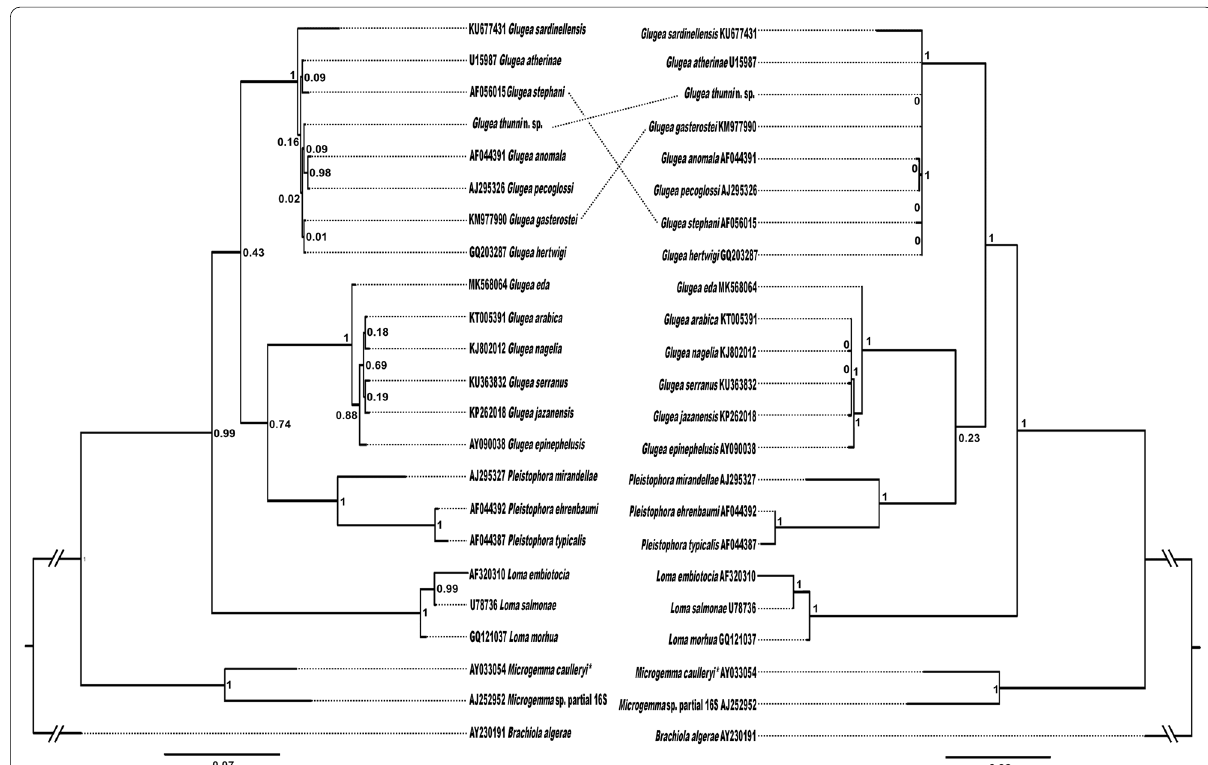
Fig. 5 Confronted bayesian inference (BI) and maximum likelihood (ML) trees for the analyses of the microsporidians based on partial 16S rDNA sequences (774 bp). Nodal support is given as posterior probabilities (BI) and bootstrap values resulting from maximum likelihood (ML); only values > 0.95 (BI) and 70% (ML) are shown. The scale‑bars indicate the expected number of substitutions per site. * Microgemma caulleryi is accepted as G. microspora in Lom